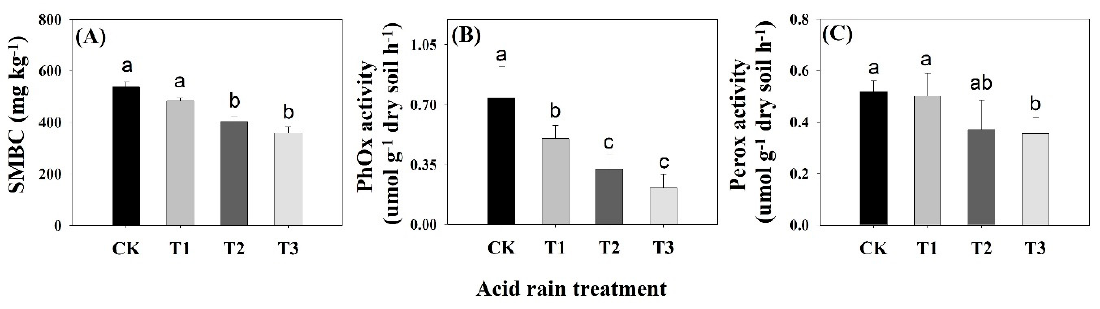
Figure 4. Soil microbial biomass carbon (SMBC, A ) and ligninolytic enzyme activities ( B , C ) under the effect of the acid rain treatments. CK is control treatment, pH ≈ 4.5; T1 is the pH = 4.0 treatment; T2 is the pH = 3.5 treatment; and T3 is the pH = 3.0 treatment. PhOx denotes phenol oxidase and Perox denotes peroxidase. Different superscript letters indicate significant differences among acid treatments at P < 0.05. Values are means ± SD.